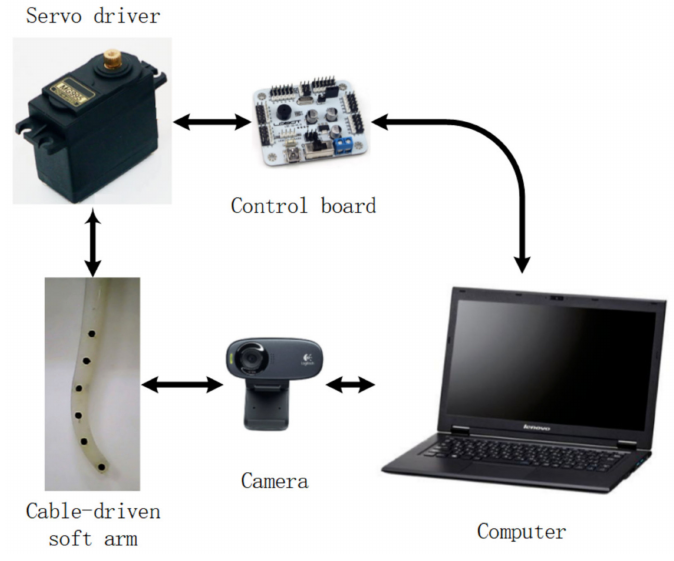
Figure 3. Hardware of